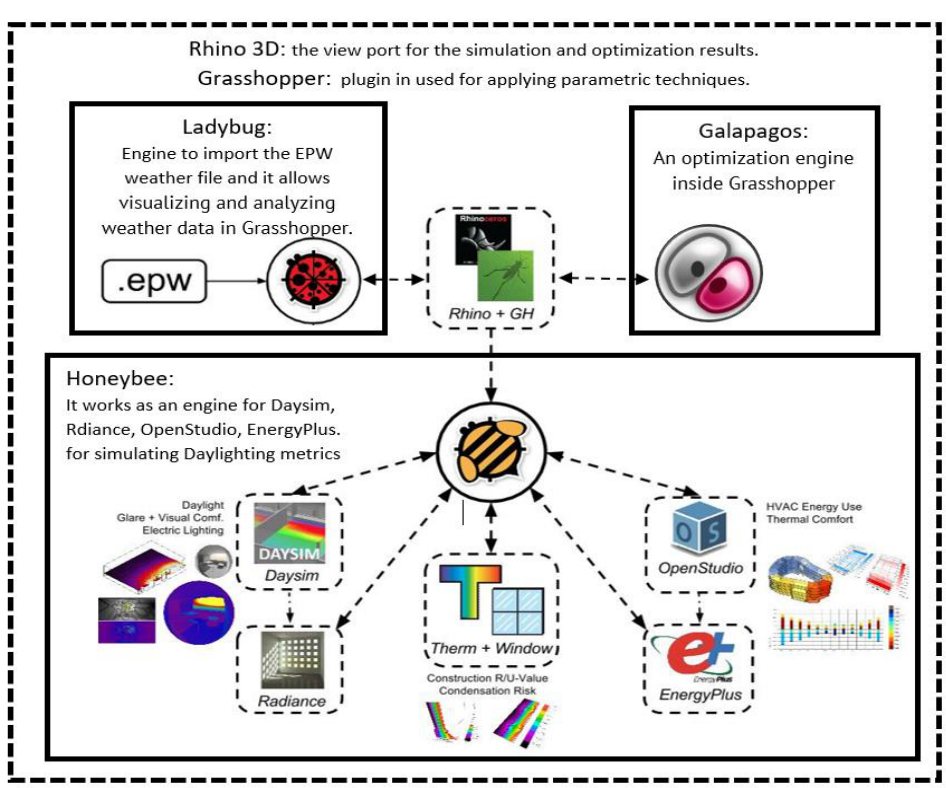
Figure 2. The links between Rhinoceros, Grasshopper, Galapagos, Honeybee, and Ladybug to generate an environmentally conscious model and simulation.